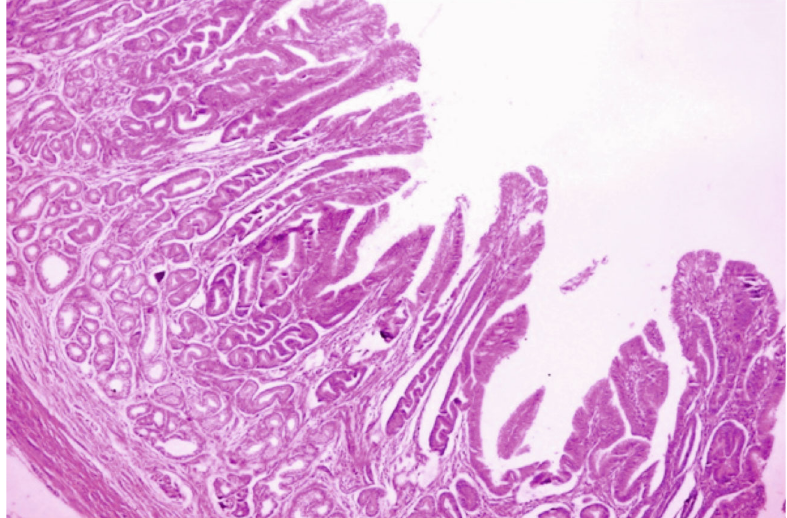
Figure 3: Photomicrograph of the thickened gastric mucosa showing a corkscrew type of foveolar hyperplasia with elongation and tortuosity along with atrophy of the underlying gastric glands (H&E, ×